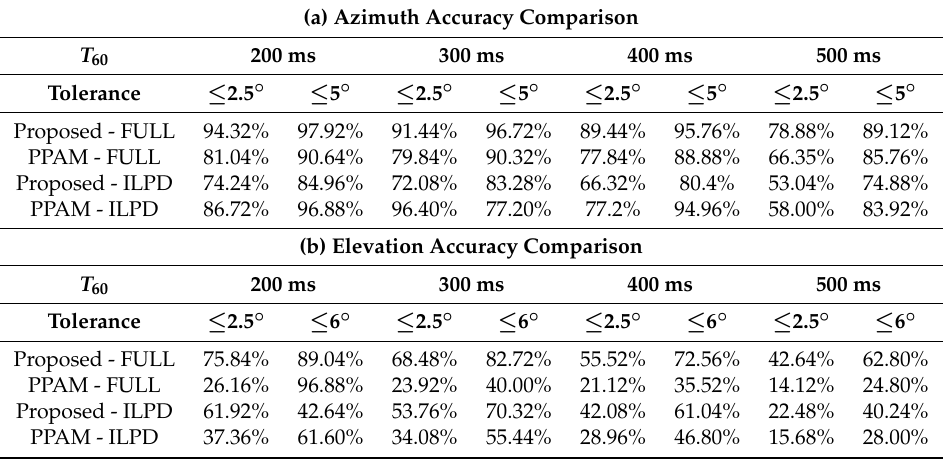
Table 3. Azimuth and elevation estimation accuracy comparison in reverberate